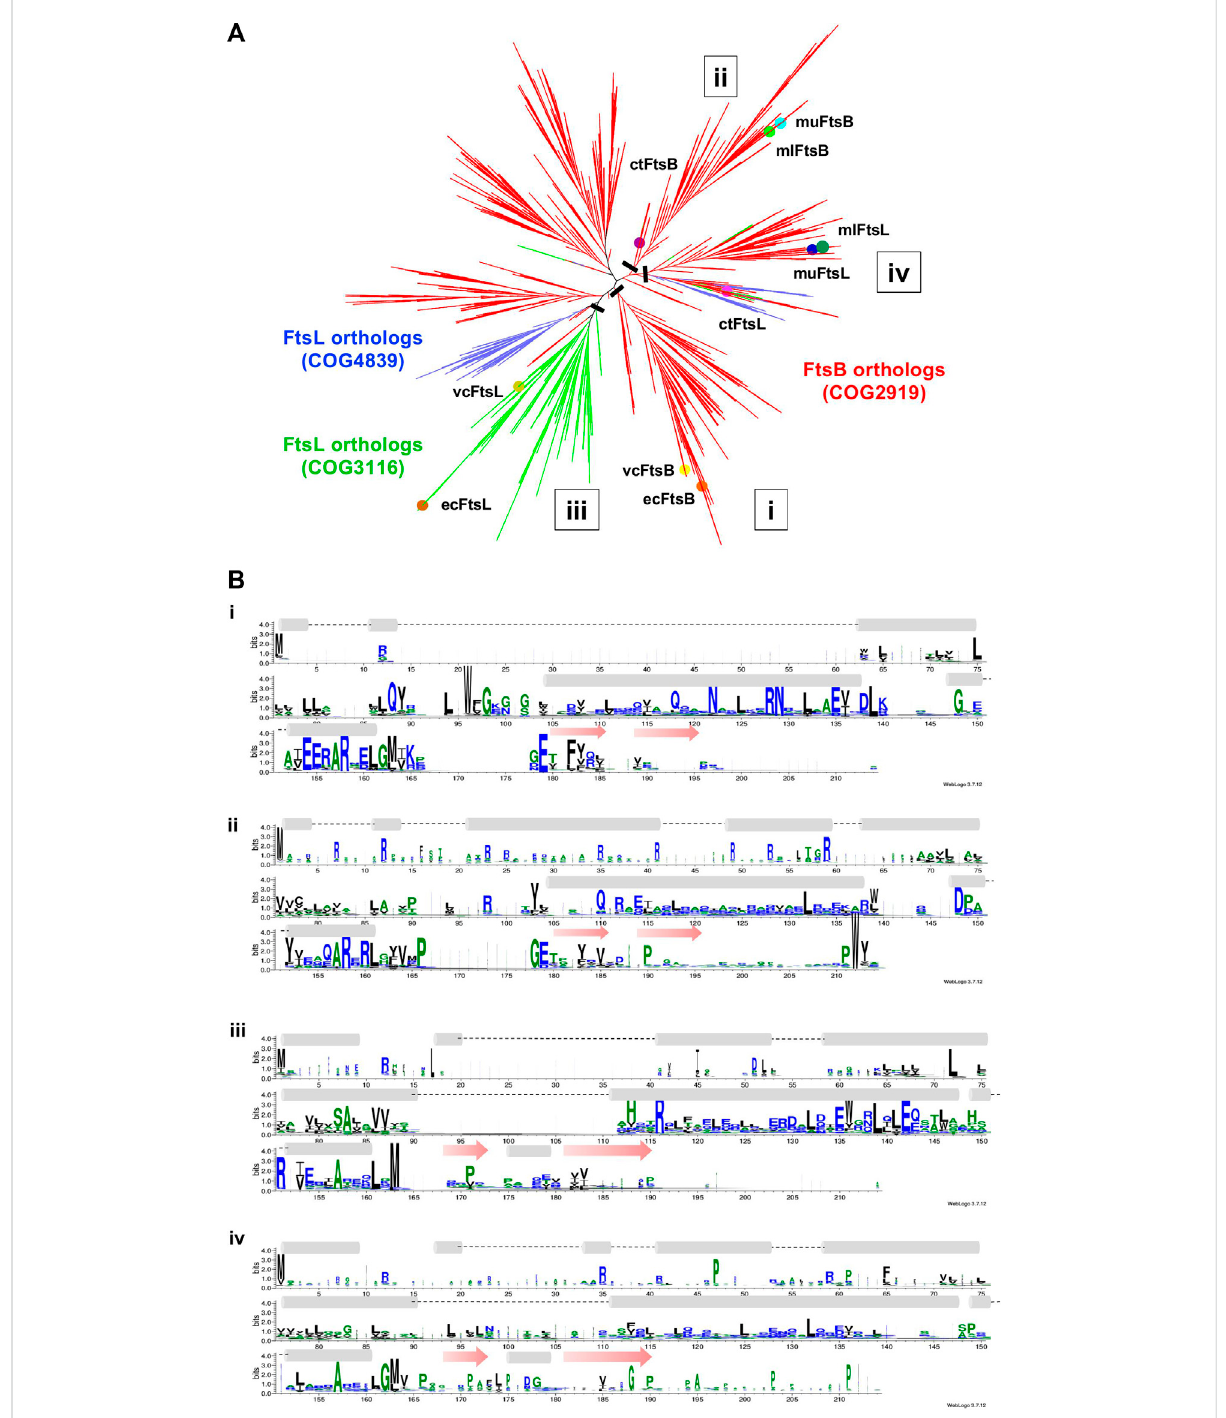
FIGURE 5 (A) Unrooted cladogram represents the phylogenetic analysis of FtsB and FtsL from diverse bacterial taxa. In the phylogenetic tree red subtree represents the FtsB COG2919, green and blue represent the FtsL COG3116 and COG4839. Nodes for FtsB and FtsL homologs are highlighted for all fi ve organisms. (B) Sequence logo for FtsB and FtsL homologs built separately for the two clades in which they are present. A black bar shows the location at which tree is